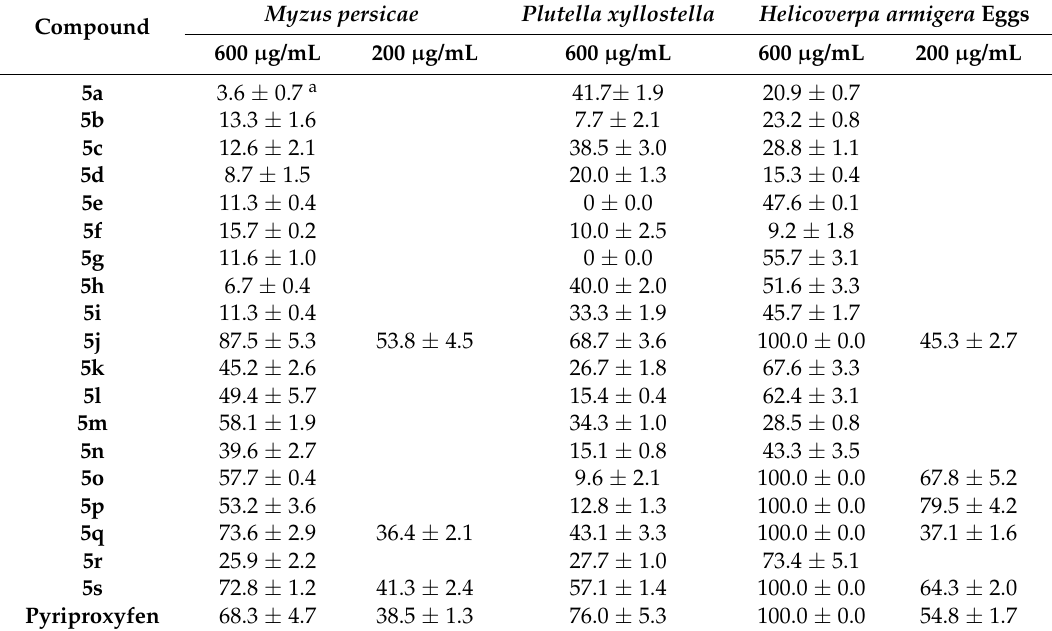
a Each value represents the mean ± the standard error of the mean (SEM) of three